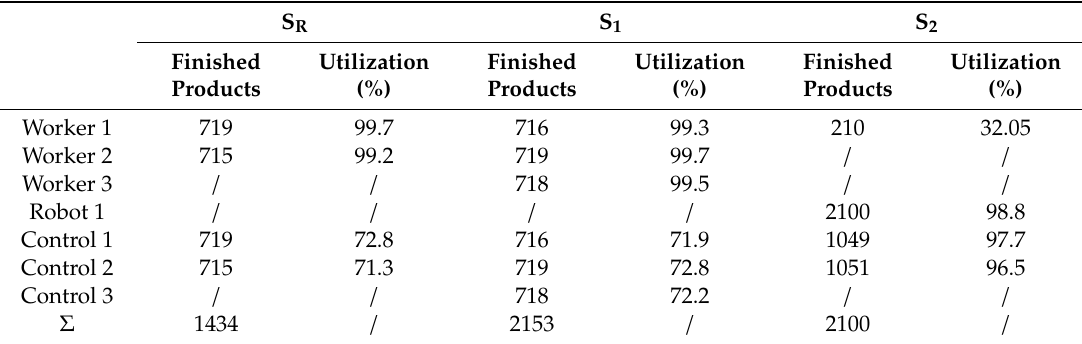
Table 3. Simulation scenarios result presenting workplace capacity.